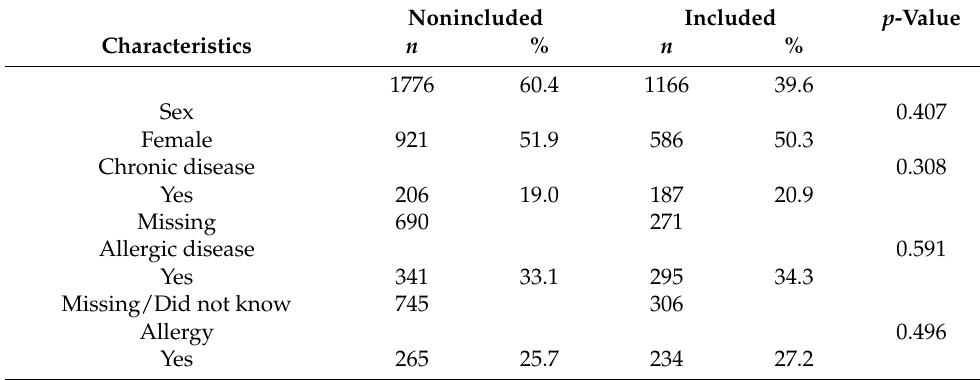
Table 1. Comparison of baseline characteristics between included and nonincluded